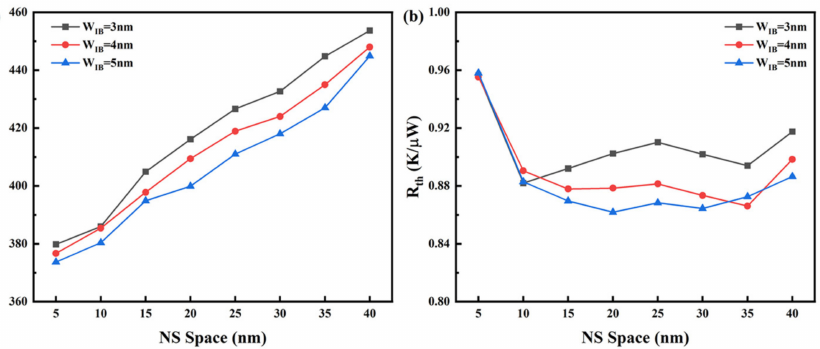
Figure 12. Impact of S NS on ( a ) T L, MAX ; ( b ) R th of the TreeFET with different W IB at V GS = V DS = 0.7 V. As S NS increased, R th rapidly decreased and then increased. Part of the heat is con- ducted through S/D to the BEOL; the substrate is the main heat dissipation path, and the other part is conducted through the gate dielectric layer, metal gate and spacer area between the channel layer. Thus, a severe thermal coupling effect exists [32–34]. The thermal coupling effect is weakened with the increase in S NS due to the increase in IB, which connects NSs and conducts heat. Moreover, the increasing temperature degrades the thermal conductivity of Silicon material. Heat is mainly dissipated through the bulk and substrate. As the S NS continues to increase, the overall thermal conduction path of the channel becomes longer, which causes worse heat dissipation and results in more total heat generating in the top channel and the increase in R th , as shown in Figures 11c and 12b,